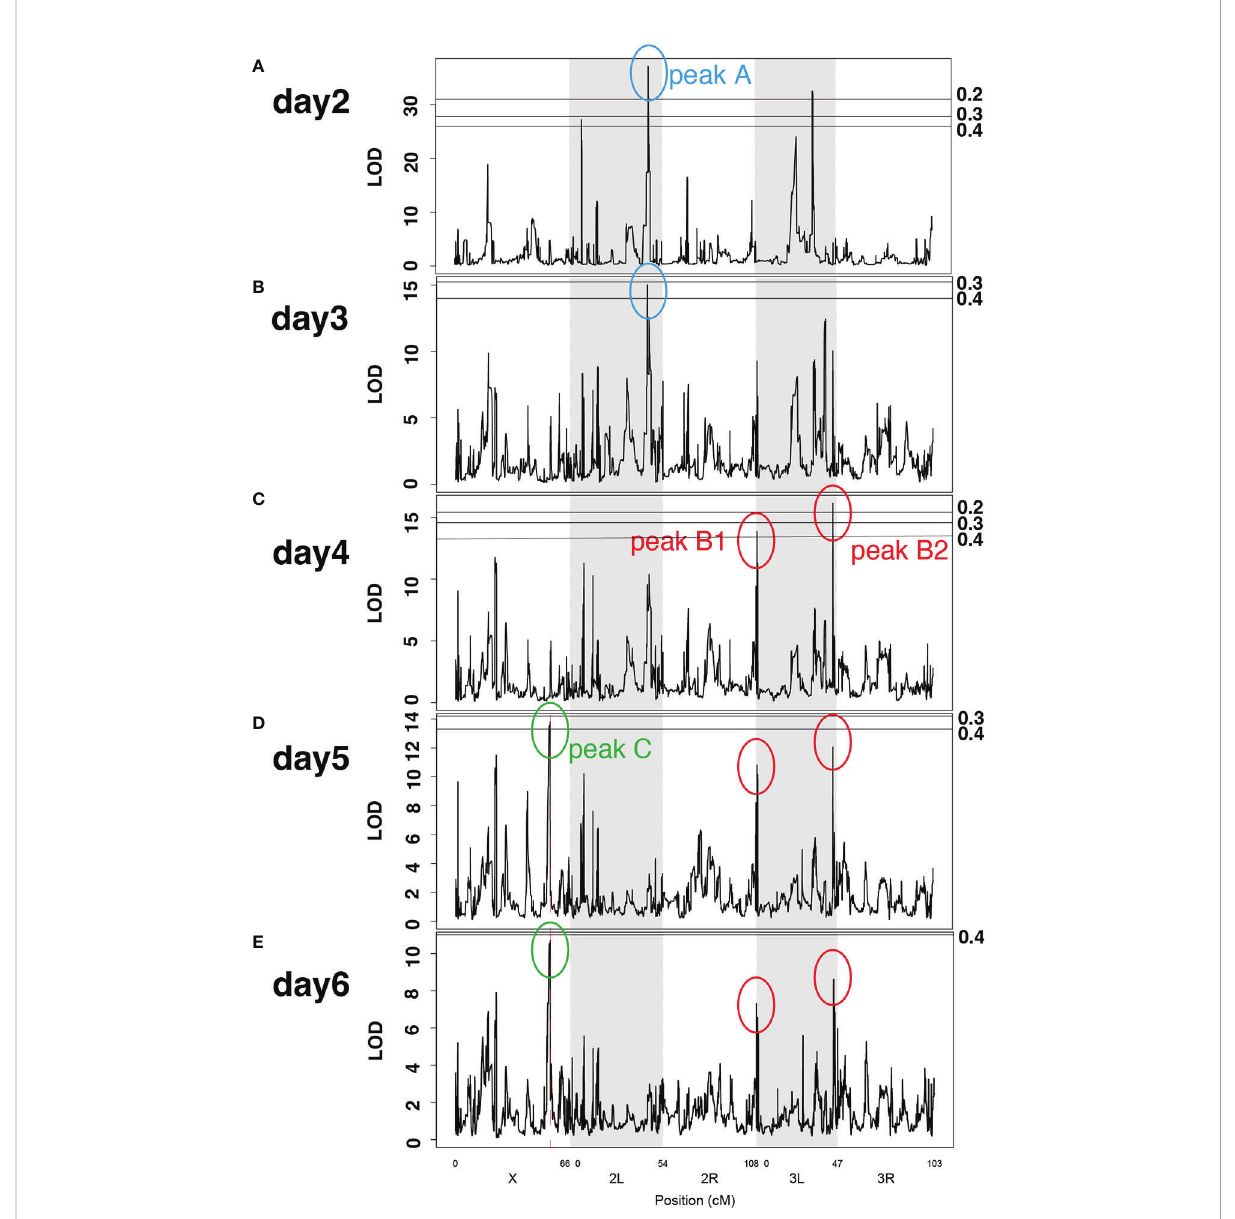
FIGURE 6 LOD peaks of training effects at different time points after challenge. Line graphs of LOD scores across Drosophila main chromosomes (X, 2L, 2R, 3L, 3R) on days 2 – 6 (A – E) after Sa challenge. Peak A was detected on days 2 and 3; peaks B1 and B2 were detected on days 4 – 6; peak C was detected on days 5 and 6. The X-axis represents the position of chromosomes. The Y-axis shows the LOD scores for each genomic position. Transverse lines represent the LOD scores corresponding to each false positive rate (numbers labeled on the right). Information on LOD peaks is provided in Table